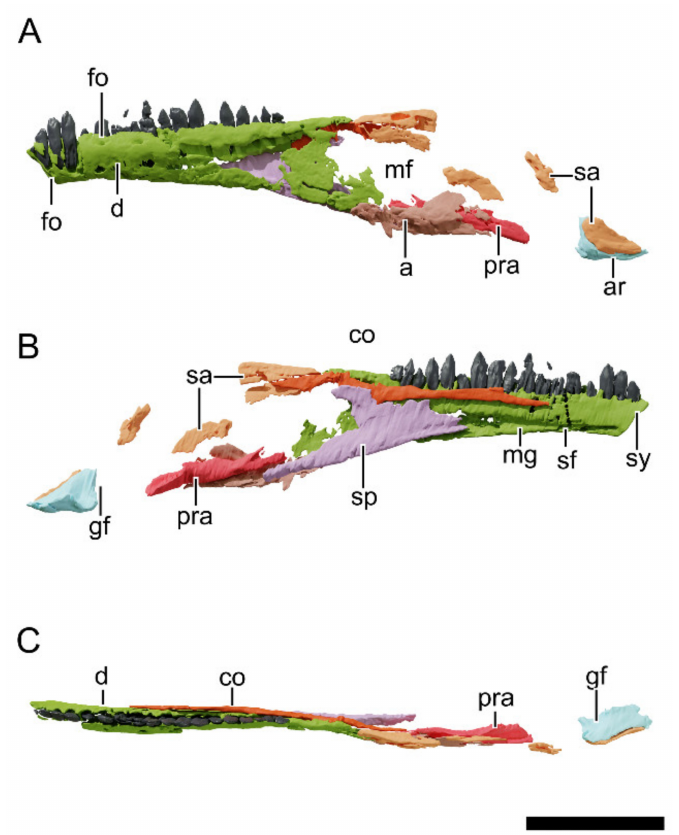
Figure 30. Digital reconstruction of the left mandible of NHMD 164741. ( A ) Lateral view. ( B ) Medial view. ( C ) Dorsal view. Abbreviations: a, angular; ar, articular; co, coronoid; d, dentary; fo, foramen; gf, glenoid fossa; mf, mandibular fenestra; mg, Meckelian groove; pra, prearticular; sa, surangular; sf, secondary fossa; sp, splenial; sy, symphysis. Scale bar = 50